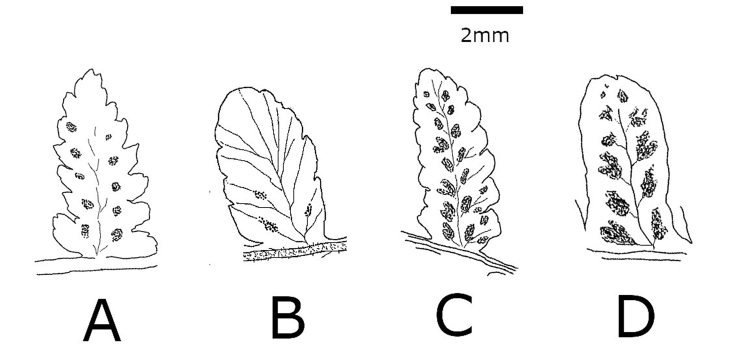
Abaxial surface of pinnule and sori of AAthyrium
crenulatoserrulatumBAthyrium
bipinnatum, CAthyrium
×
christensenianumDAthyrium
decurrentialatum (illustration by K. Hori).